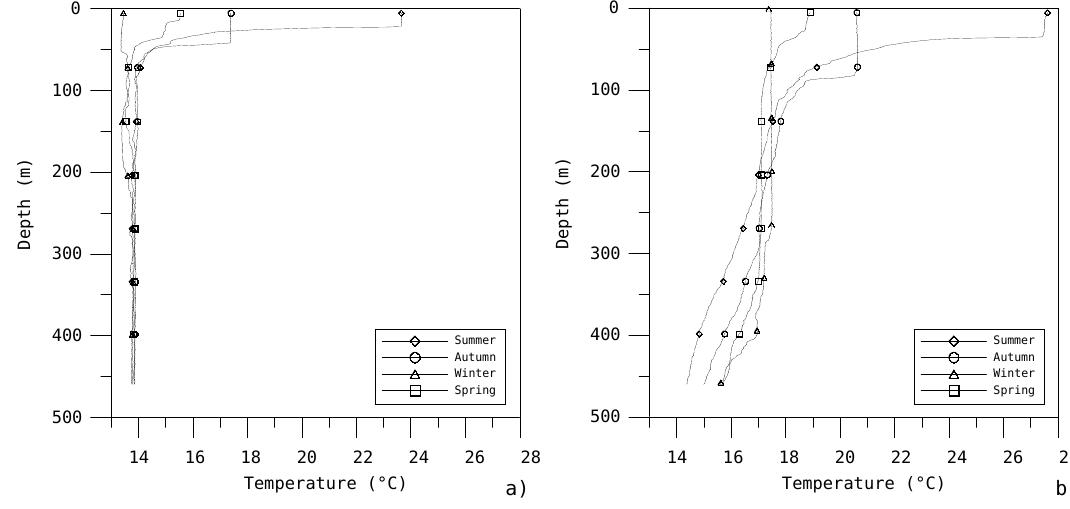
Fig. 6. Seasonal variability of thermocline from XBT data (a) in the Bonifacio Gyre, (b) in the Shikmona Gyre.